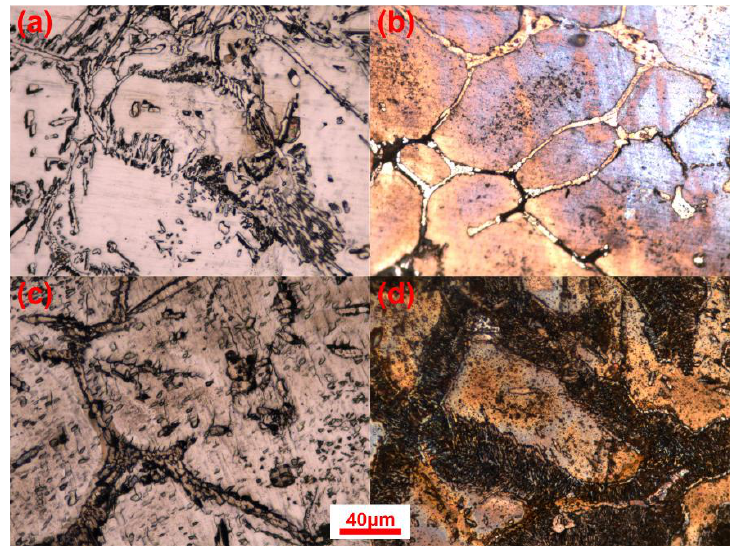
Figure 12. Alloy microstructure after a series of heat treatments. ( a ) Alloy #1; ( b ) alloy #2; ( c ) alloy #3; and ( d ) alloy #4.